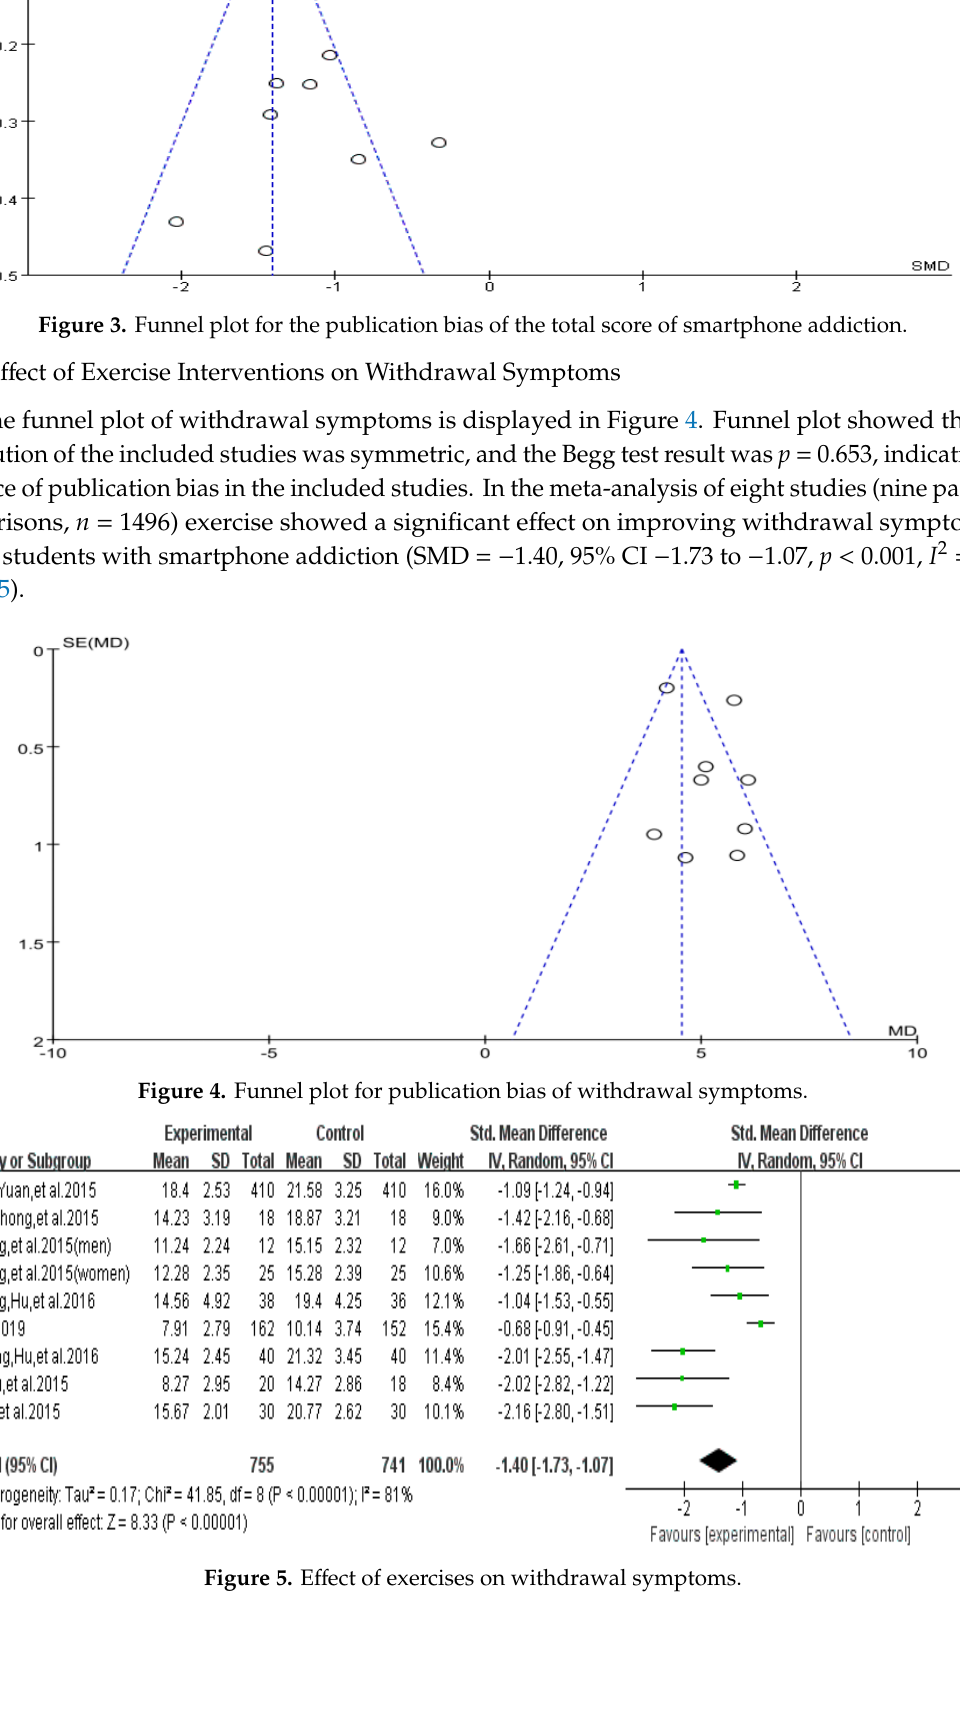
Figure 5. Effect of exercises on withdrawal symptoms.